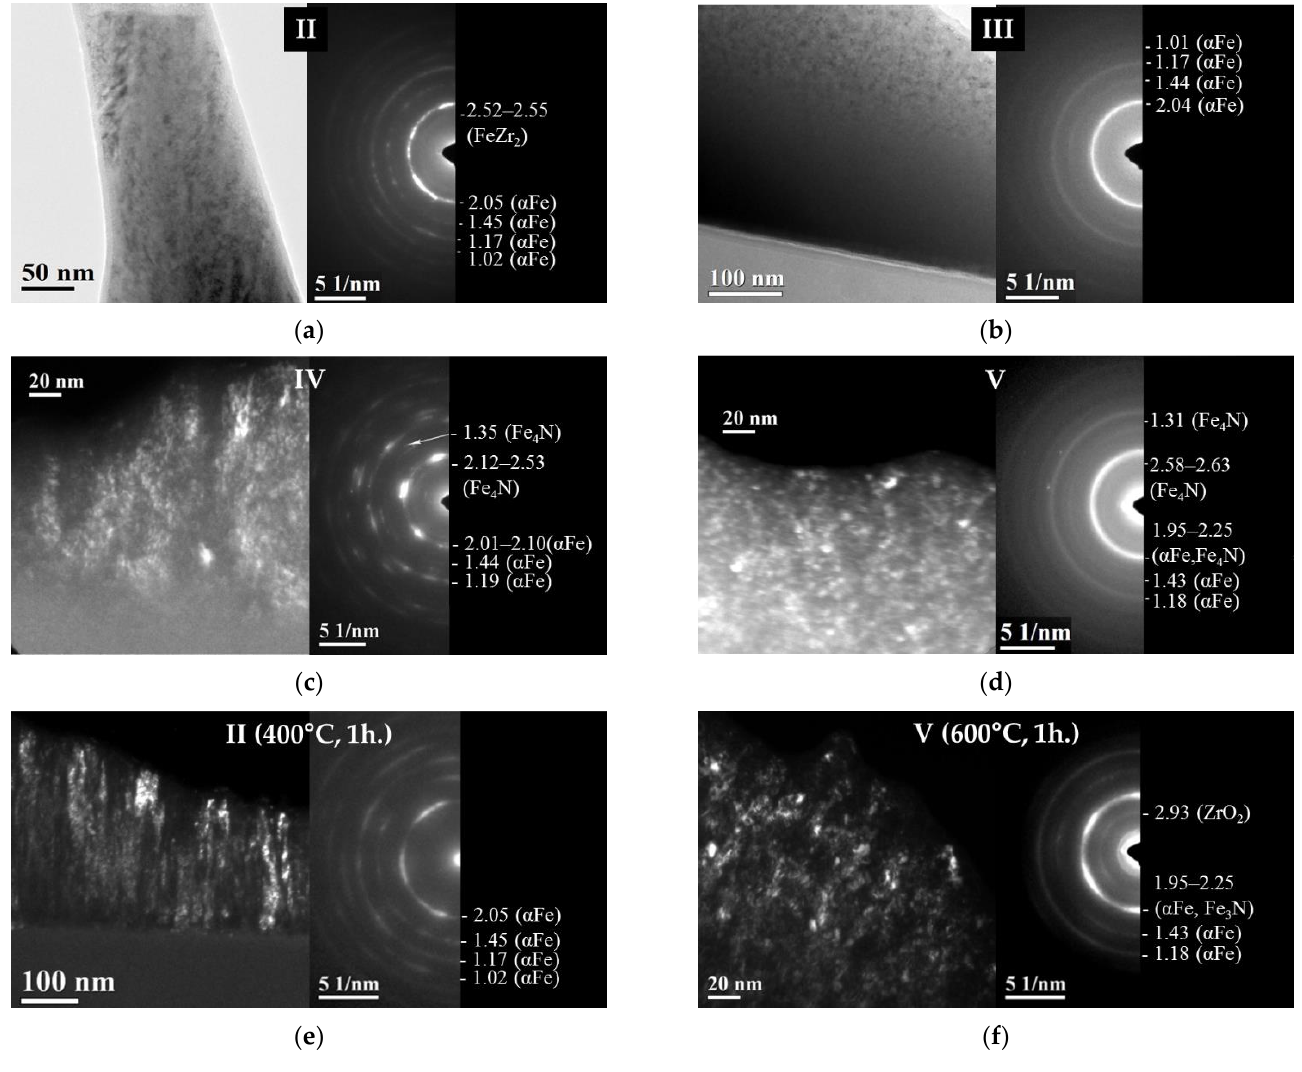
Figure 5. TEM images and corresponding SAED patterns taken for the as-deposited films II ( a ), III ( b ), IV ( c ), V ( d ), and films II ( e ) and V ( f ) annealed for 1 h at 400 and 600 °C, respectively. Dark-field images ( c – f ) were taken using the fragments of the rings, corresponding g = 110 for the bcc phase and g = 111 for the fcc phase.